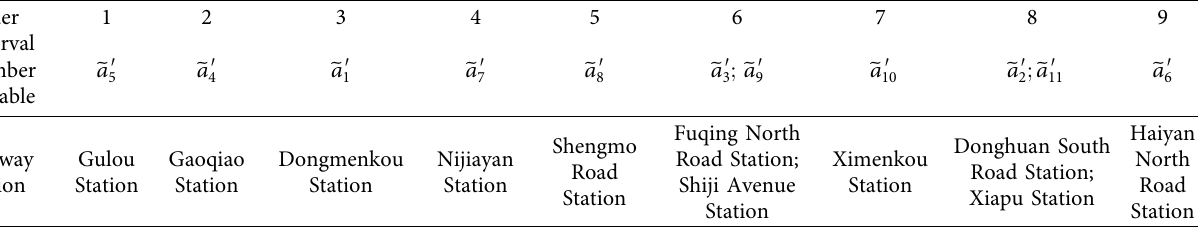
Table 5: Ranking result of waiting time.